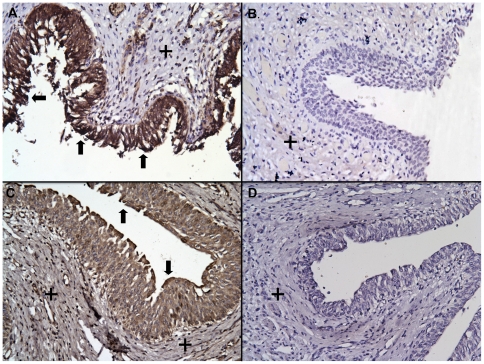
HD5 is expressed throughout the urothelium of the ureter and bladder.Immunohistochemistry demonstrates HD5 expression (brown/arrows) throughout the urothelium of the human bladder (A) and ureter (C). Immunostaining was most prominent in the luminal surfaces (brown/arrows). Immunostaining was not detected in the smooth muscle layers of the bladder or ureter (+). Negative control bladder (B) and ureter (D) showed no immunostaining. Magnification 20×.